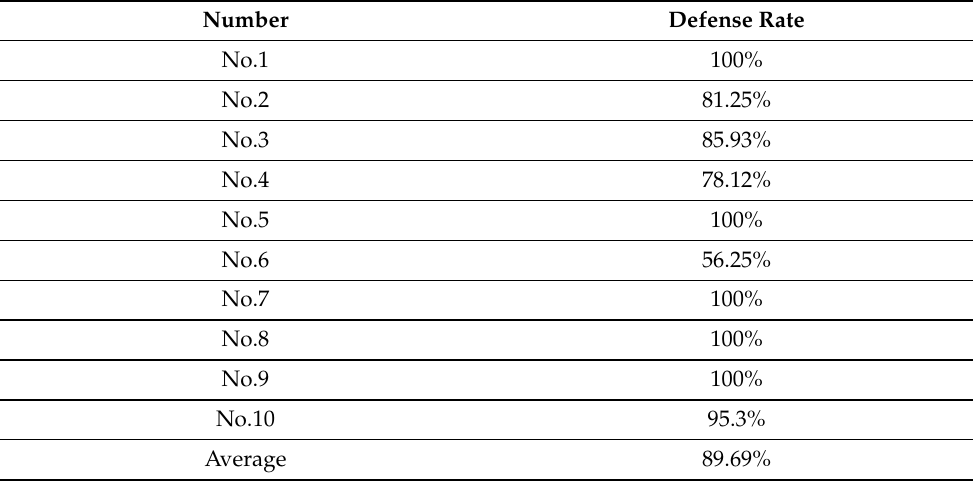
Table 16. Dodging defense rate after